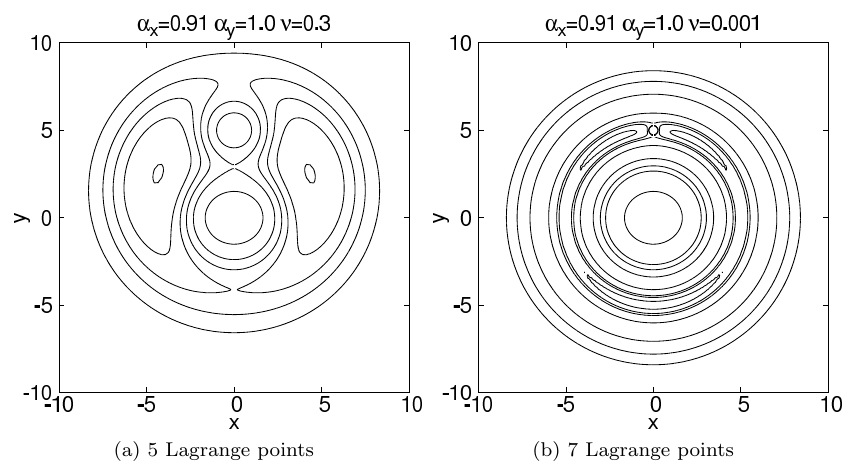
Fig. 3. Zero velocity curves and equilibrium points for two short axis relative equilib- rium configuration with 5 (left) and 7 (right) Lagrange